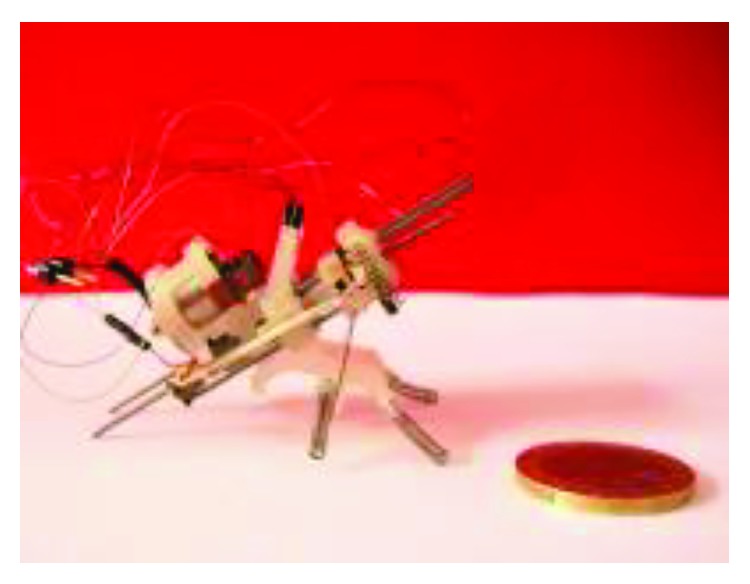
Jumping robot Grillo [39].